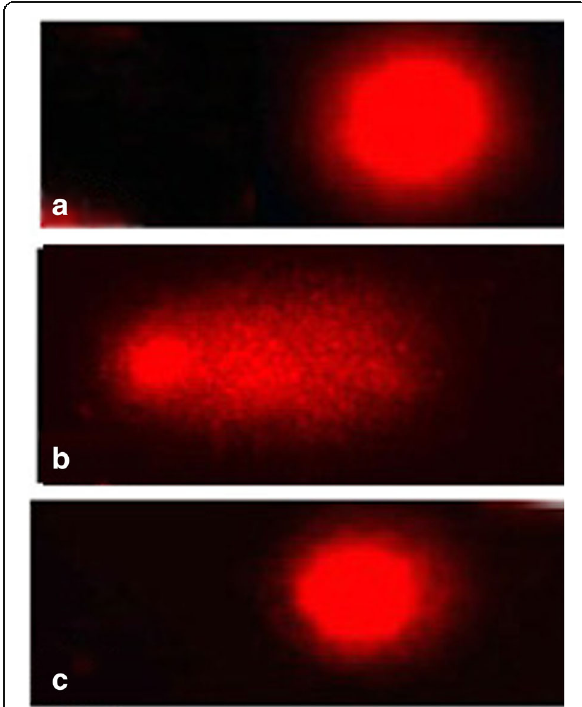
Fig. 4 Fluorescent microscope photomicrographs of hepatic cells. a Normal DNA spots (no migration). b CP-treated rat shows strong damaged DNA spots (migration towards the anode). c Hepatocyte of rat treated with ABG + CP showing improvement in DNA and reduction of damaged spots (bromide ethidium staining, × 400)